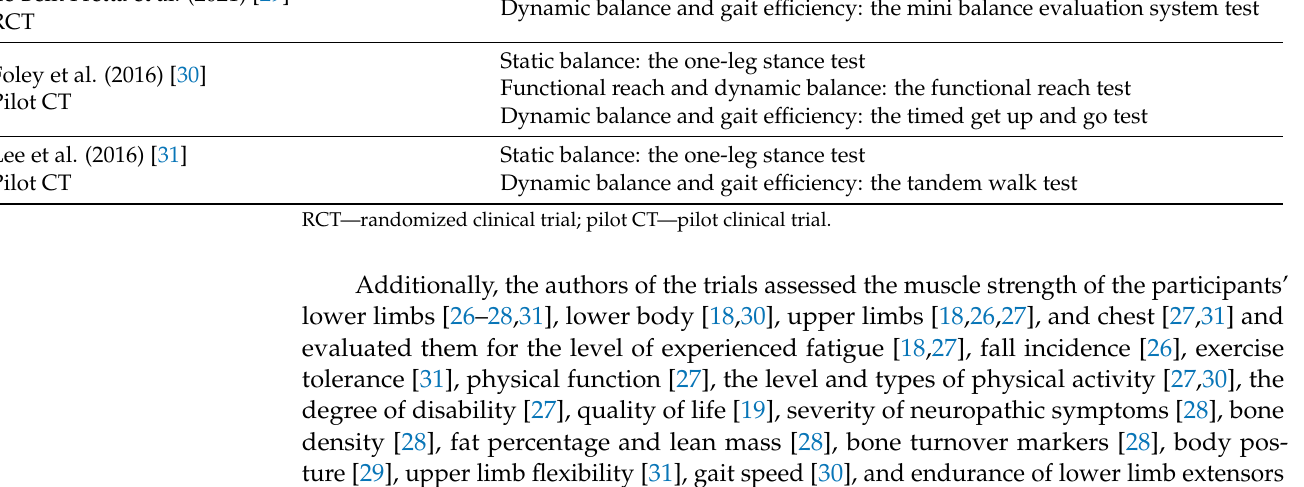
Methods of Body Balance